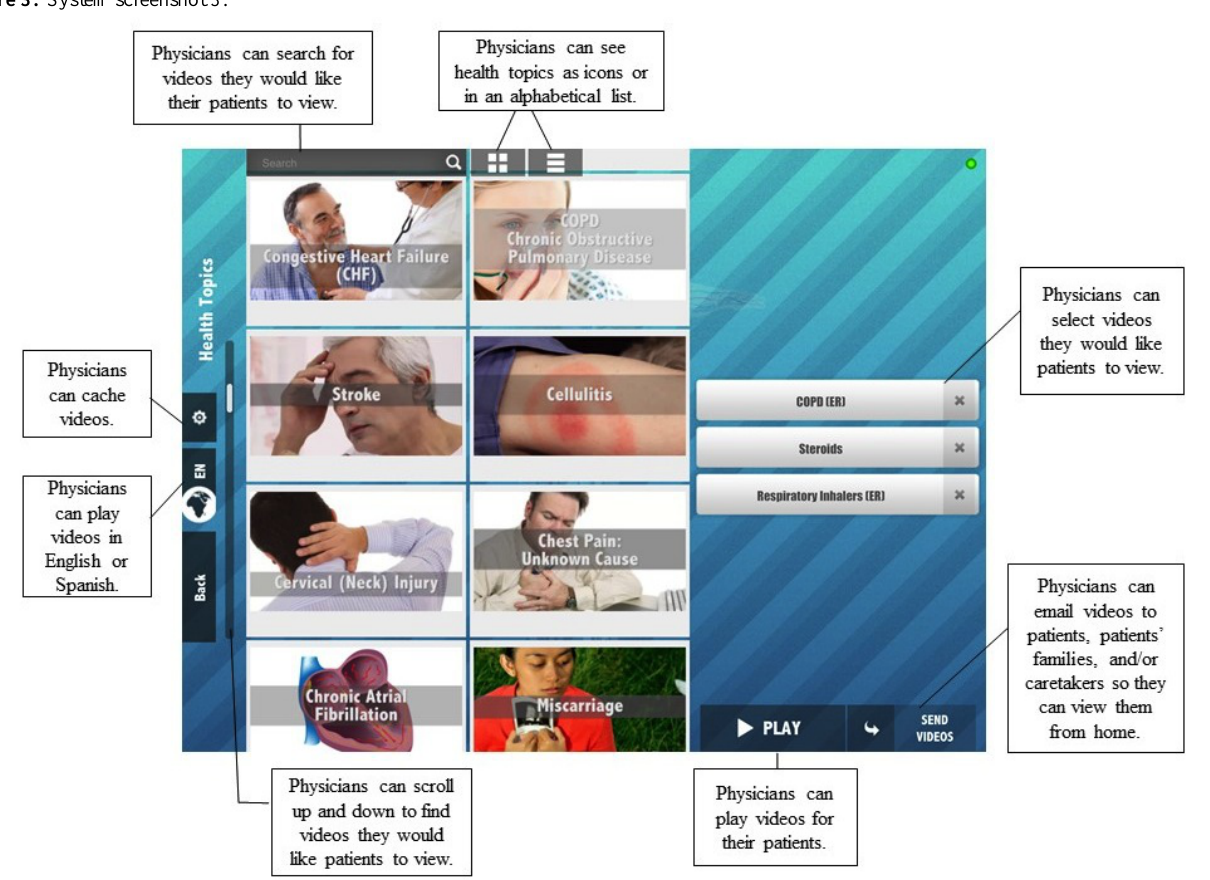
Figure 3. System screenshot